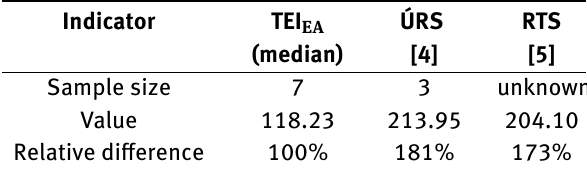
Table 7: Comparison of TEI E A values with ÚRS and RTS indicators [EUR/m 3 ].